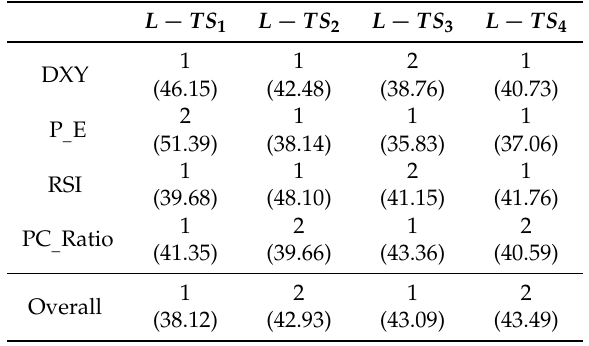
Table 9. Relations among instance nodes and S&P 500 during the four regimes. The bottom row shows the overall impact on the S&P 500. Numbers code the behavior in the market: In-Trend (1), Reversal (2), and Sideward (0). Corresponding probability is given between brackets.